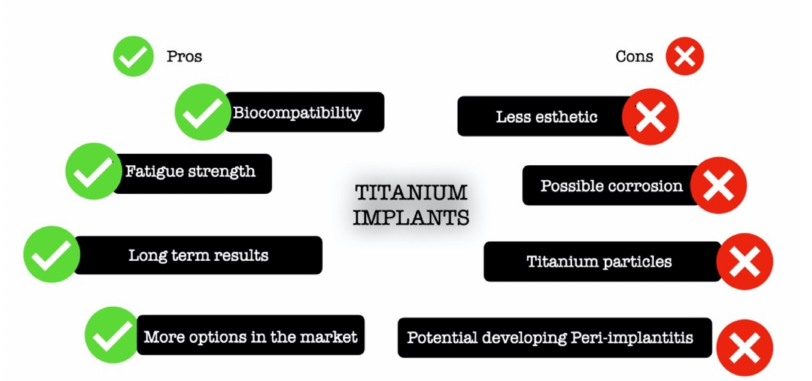
Figure 2. Schematic illustration of advantages and drawbacks of titanium